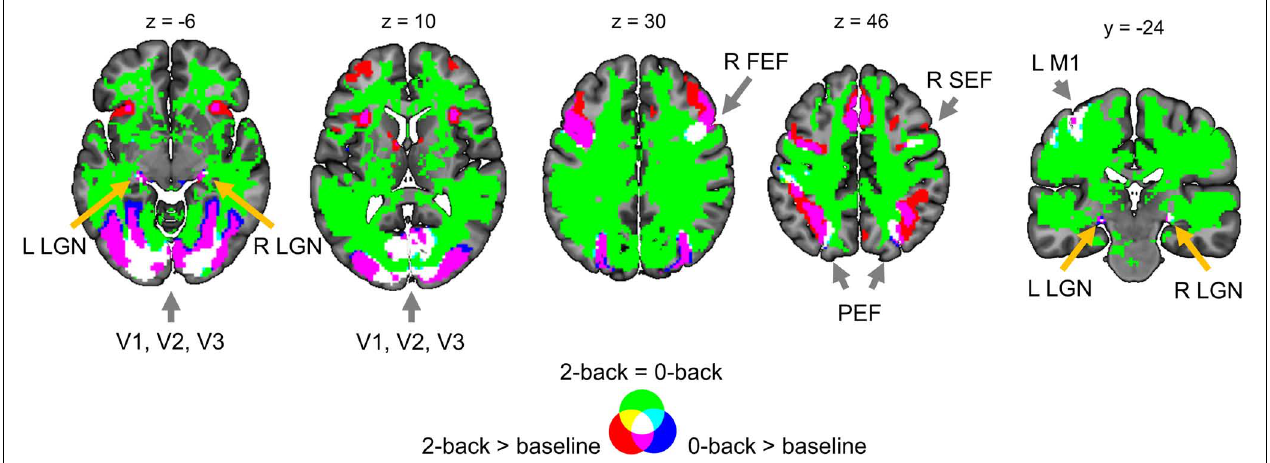
FIGURE 19 | Example of possible application of BPI based on the working memory task. L/R, left/right; V1, V2, V3, primary, secondary, and third visual cortex; FEF, frontal eye field; SEF, superior eye field; PEF, parietal eye field; LGN, lateral geniculate nucleus; M1, primary motor